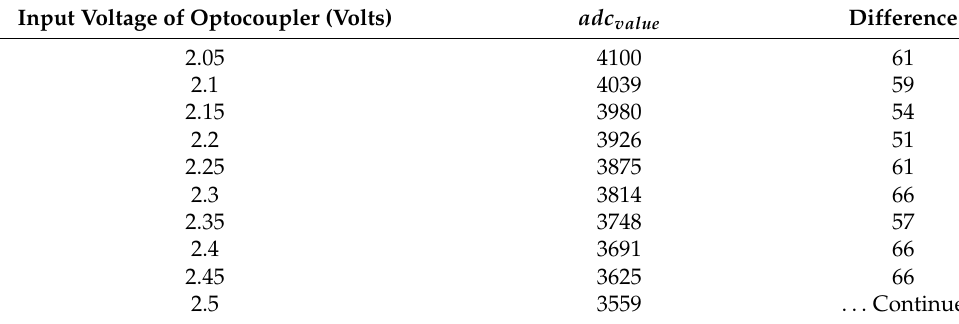
Table 1. Sample Values of the Proposed